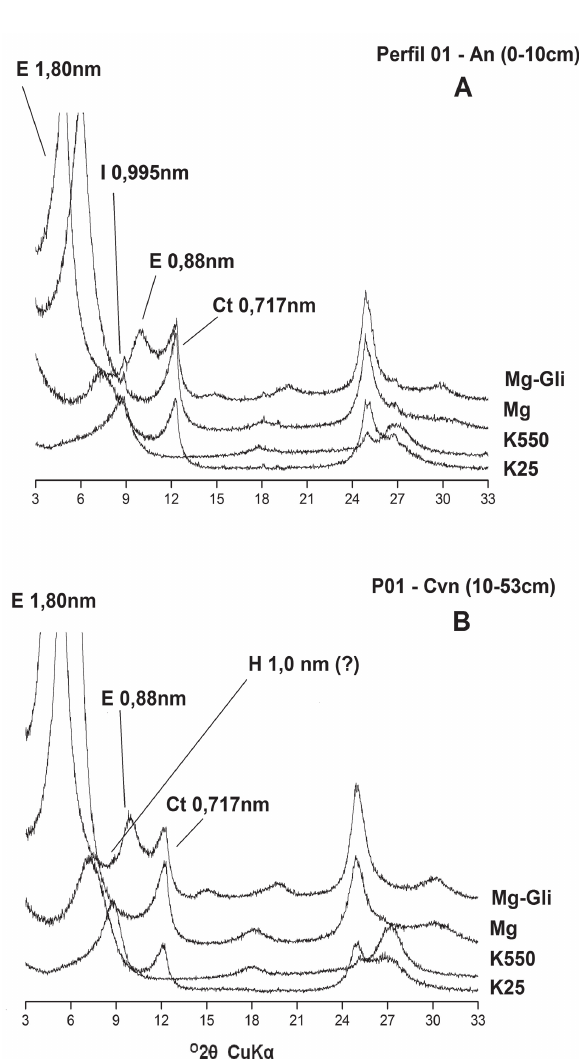
Figura 2. Difratogramas de raios-X da fração argila natural dos Vertissolos de Fernando de Noronha, PE, estudados (E-esmectita; Ct-caulinita; Gt- goethita; Hm-hematita; e Fd-feldspatos).